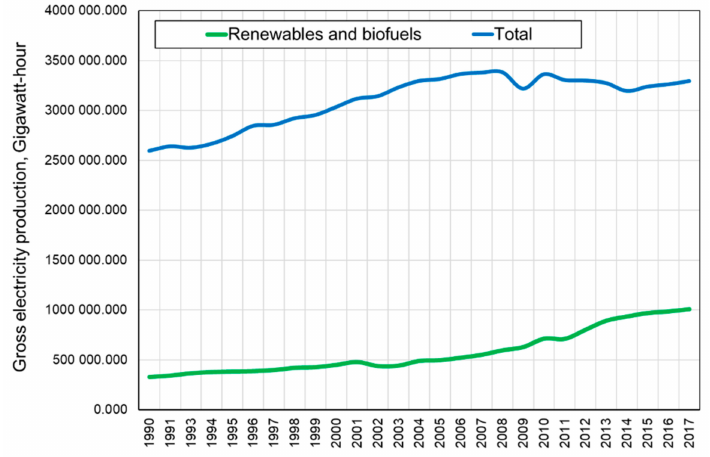
Figure 2. Total energy production in the EU countries between 1990–2017, including energy produced from renewable energy sources (own study based on data from